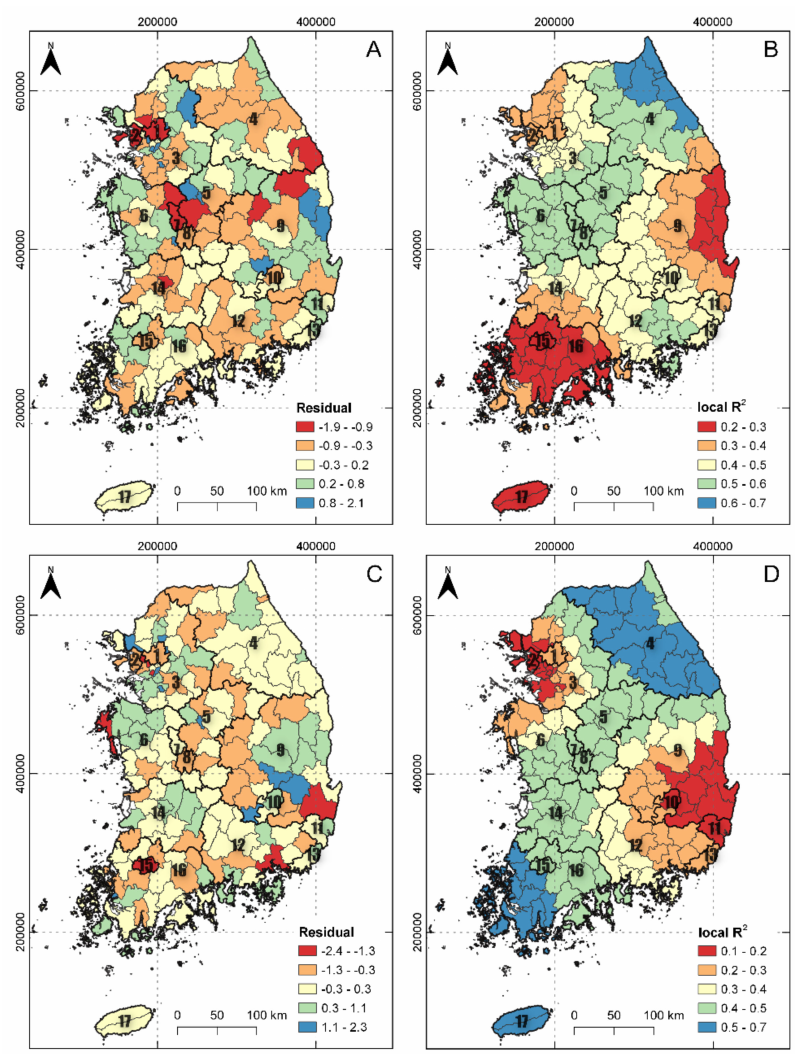
Figure 4. Spatial mapping of the residual and locally weighted coefficients of determination ( R 2 ) of A. pilosus density ( A , B ) and L. scariola density ( C , D ) in geographically weighted regression